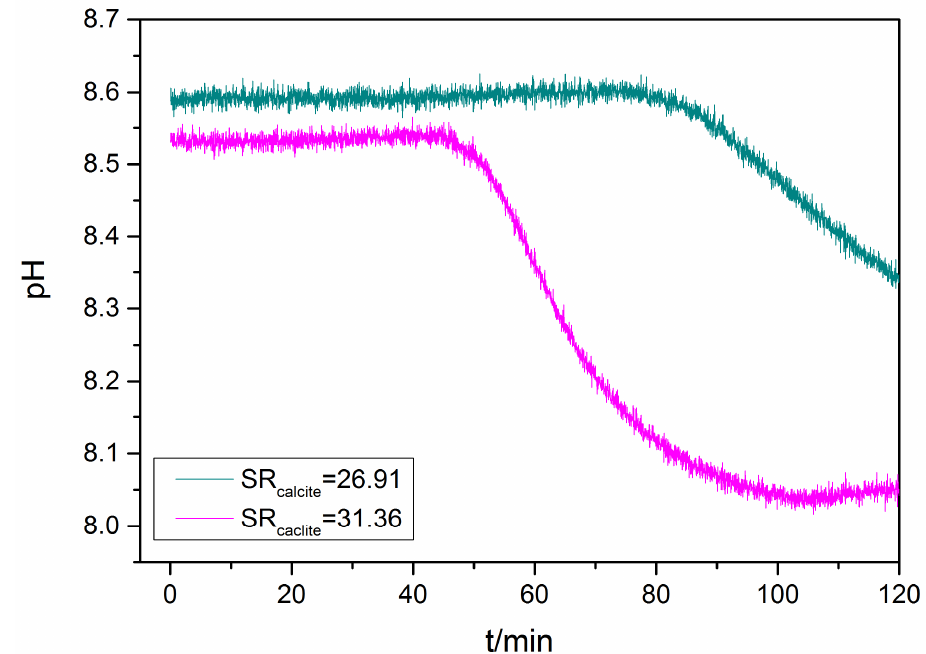
Figure 7. Precipitation of calcium carbonate in the presence of 6.0 μ M of nickel (under illumination in the presence of 20 mL of active A. obliquus culture (including nutrient medium). pH variation as a function of time; 25 °C, pH 8.50, 0.15 Μ of NaCl. At higher supersaturation (red line), precipitation starts earlier and at a higher rate. The rates of calcium carbonate precipitation were calculated from the calcium concentration time profiles, corresponding to the pH time profiles, and the results are summarized in Table 4.